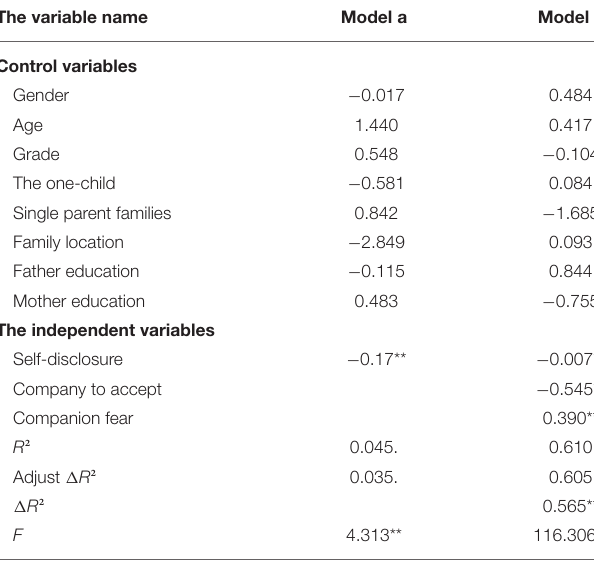
TABLE 3 | Regression analysis of self-disclosure, peer relationship and